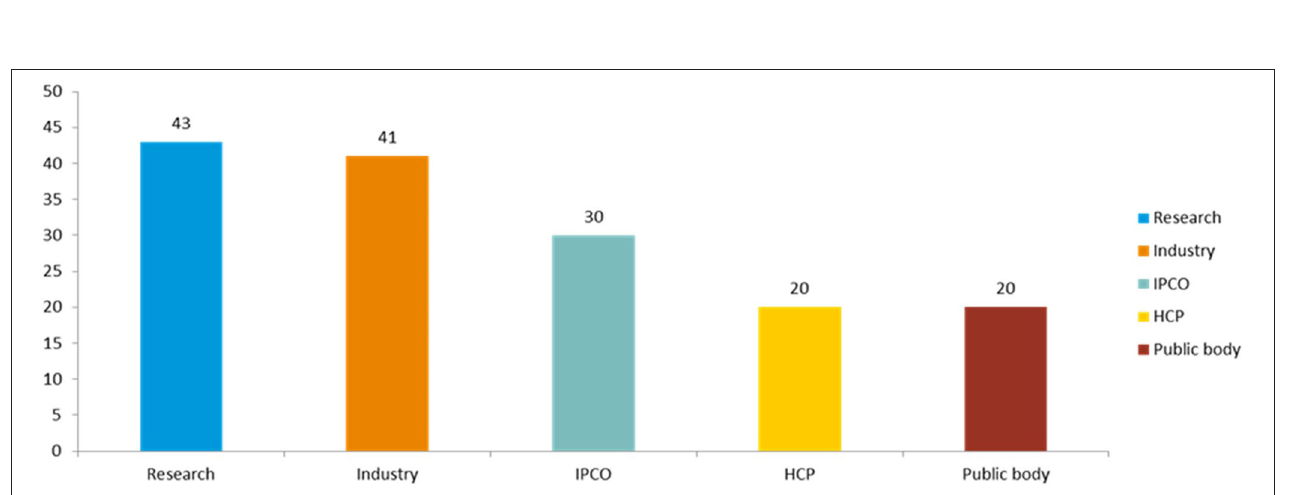
FIGURE 1 | Clustering of survey respondents. The survey respondents were clustered into 5 groups: cluster 1 (IPCO + ) contained “individual members of the public,” “patient or consumer organizations,” and “advocacy groups”; cluster 2 (HCP) contained “health care professional organizations,” “health care professionals,” and “veterinarians”; cluster 3 (Research) contained “academic researchers” “learned society,” “European research infrastructures,” and “other scientific organizations”; cluster 4 (public bodies), contained “EU regulatory partners/EU institutions,” “health technology assessment bodies,” and “payers”; cluster 5 (Industry) contained “pharmaceutical industry” (“individual companies,” “SMEs,” and “trade associations”).